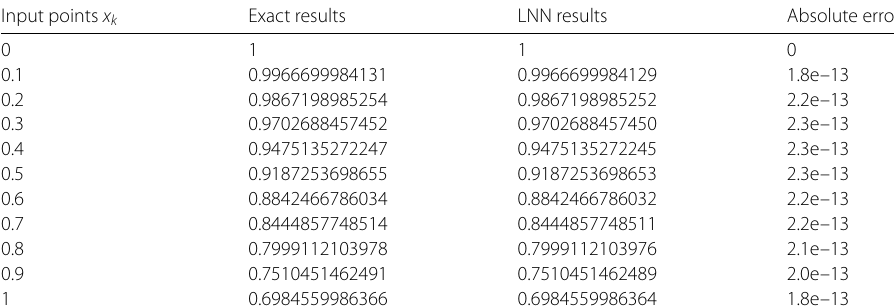
Table 10 Exact and LNN neural network